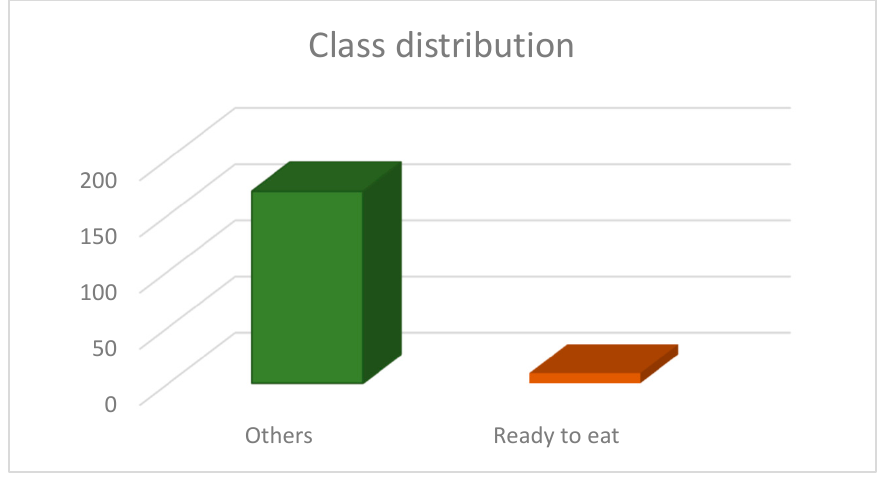
Figure 1. Distribution of ‘others’ and ‘ready to eat’ classes of peaches in the Model A dataset.